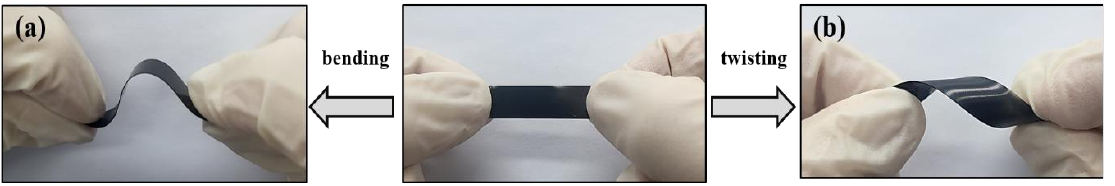
Figure 3. Photo images of 20 BL PANi/SWNT-PEDOT:PSS thin films deposited on the PET substrates by spraying coating method, demonstrating its flexibility by ( a ) bending and ( b ) twisting.